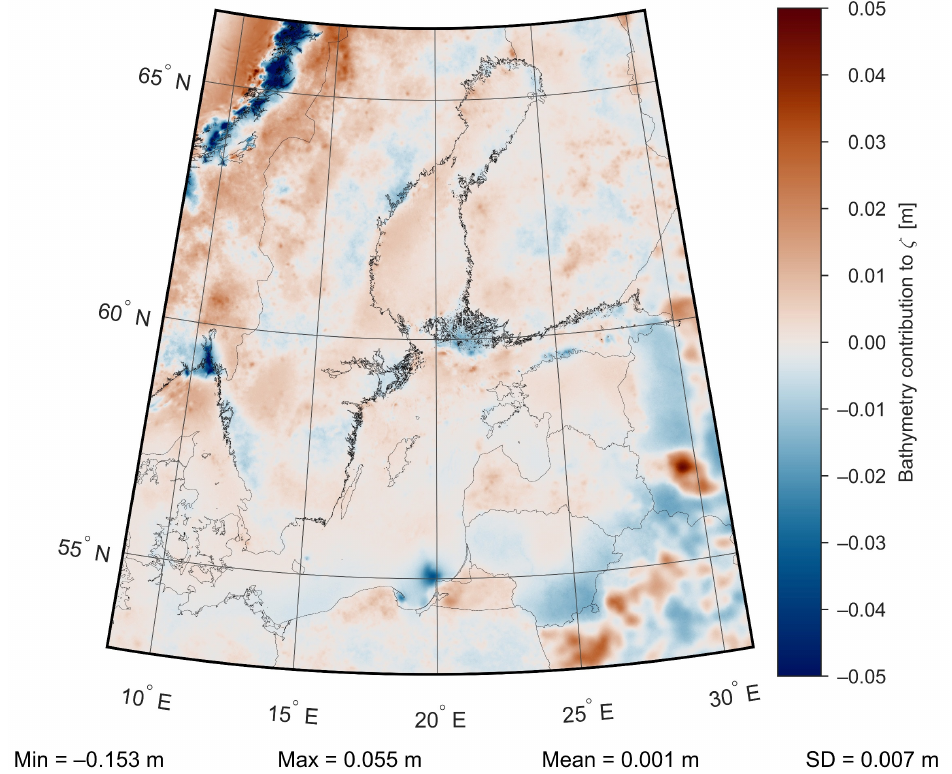
Figure 15. Bathymetry contribution to geoid modeling results. GGM: GOCO05c, modification limits: